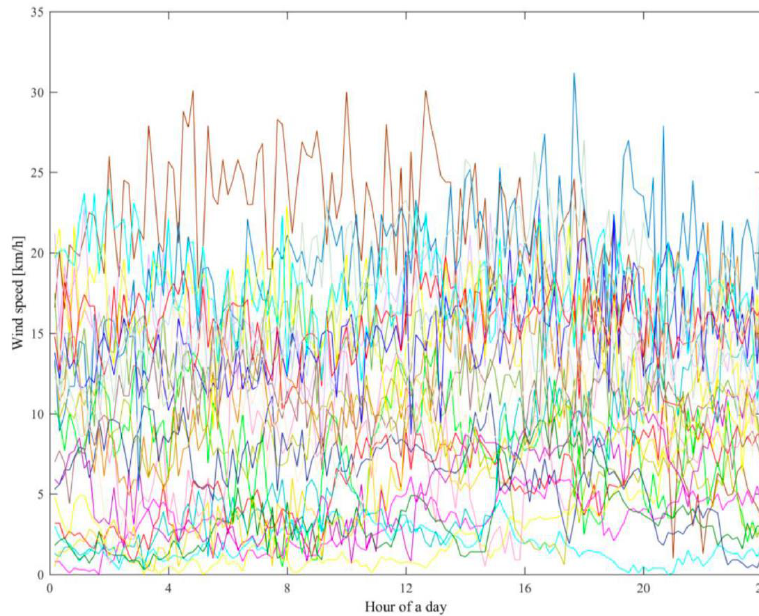
Figure 11. Measured wind speed for 50 days at Khaaf, Iran [15].